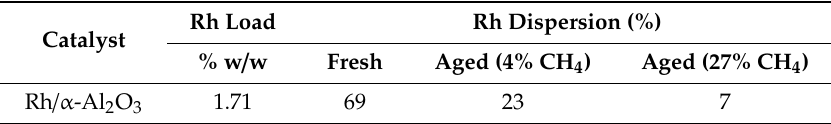
Table 2. Catalyst morphological characteristics.